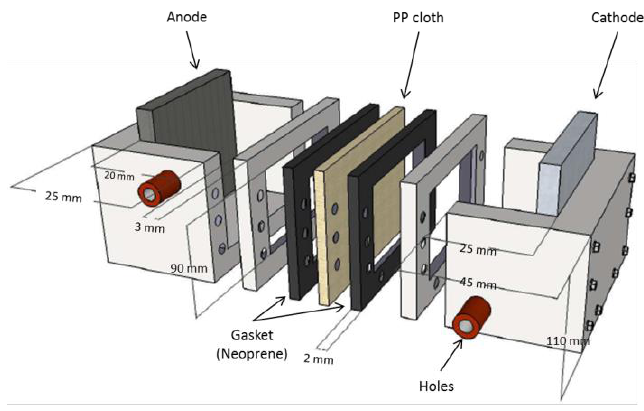
Figure 2. Laboratory-made cell for electro-assisted leaching and electrodeposition in aqueous media.